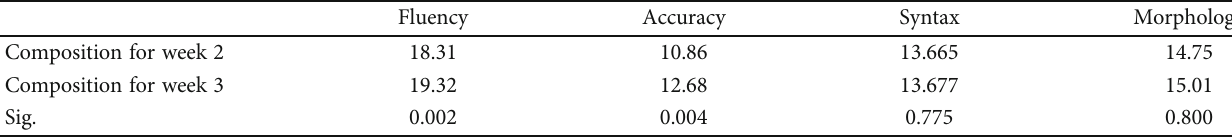
Table 5: Wechsler ’ s signed-rank test of composition for weeks 2 and 3.